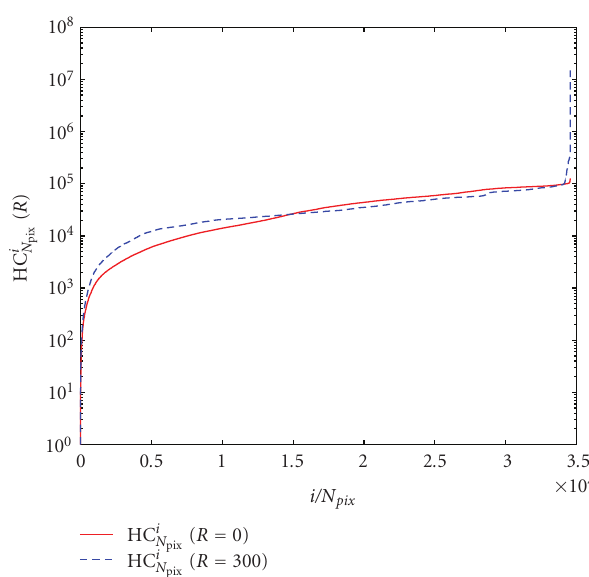
Figure 5: The HC i values obtained from the analysis of the QVW N pix map. The solid red line corresponds to the application of (12) to the CMB map in the real space (i.e., R ≡ 0) whereas the dot-dash blue line corresponds to the analysis of the SMHW coe ffi cients at scale curves are normalized by their respective R = 300 arcmin. HC i N pix minimum